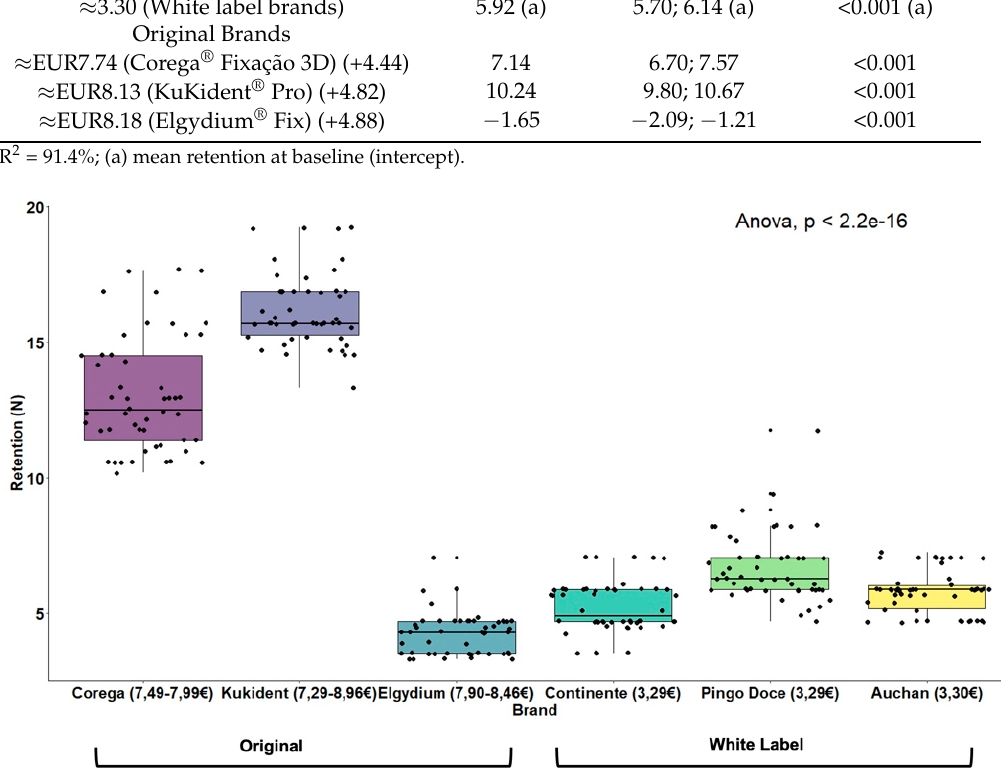
Table 6. The retention capacity of the adhesives in descending order, their characteristics, and their relation with